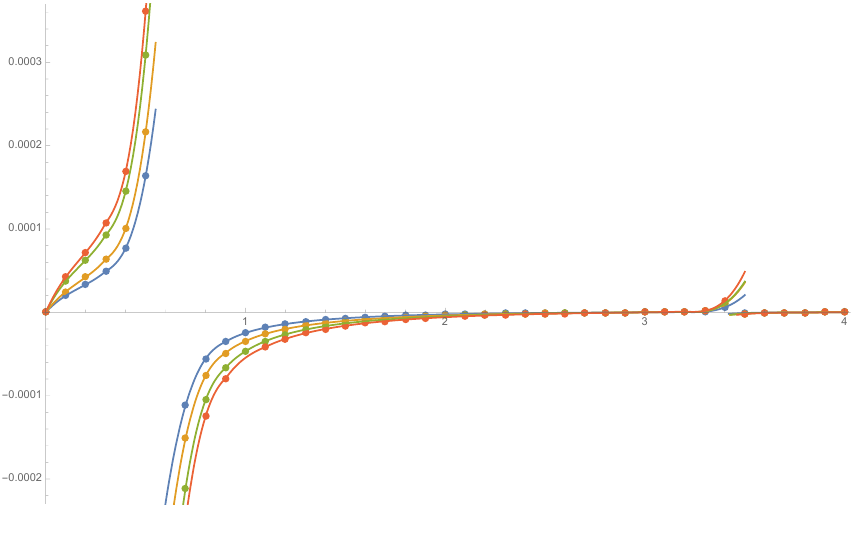
Figure 3 . The ratio A (cid:8) =A (cid:8) as a function of Q for L = 5 ; 6 ; 7 ; 8 (blue, h 1 = 4 ; (cid:0) 4 ;h 1 = 4 ; 4 h 1 = 2 ; (cid:0) 2 ;h 1 = 2 ; 2 orange, green and red dots respectively). This ratio is generically non zero. It exhibits (in (cid:12)nite size) simple poles at Q = 4 cos 2 (cid:25) , Q = 4 cos 2 4 (cid:25) , and vanishes exactly (in (cid:12)nite size) for Q = 0 ; 3 ; 4. 8 8